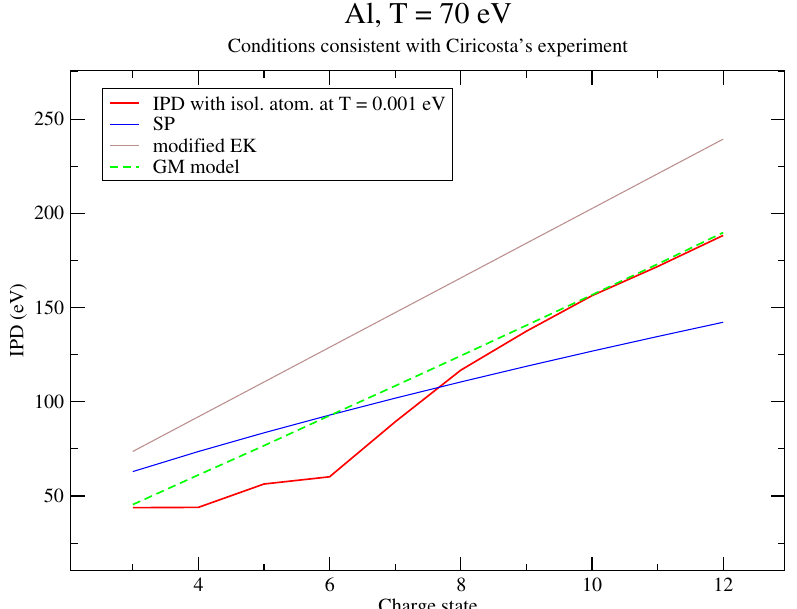
Figure 8. IPD of the different charge states for an aluminum plasma at T = 70 eV: our calculation (red curve), Stewart-Pyatt model (blue curve), modified Ecker-Kröll model (brown curve) and GM model (green dashed curve).